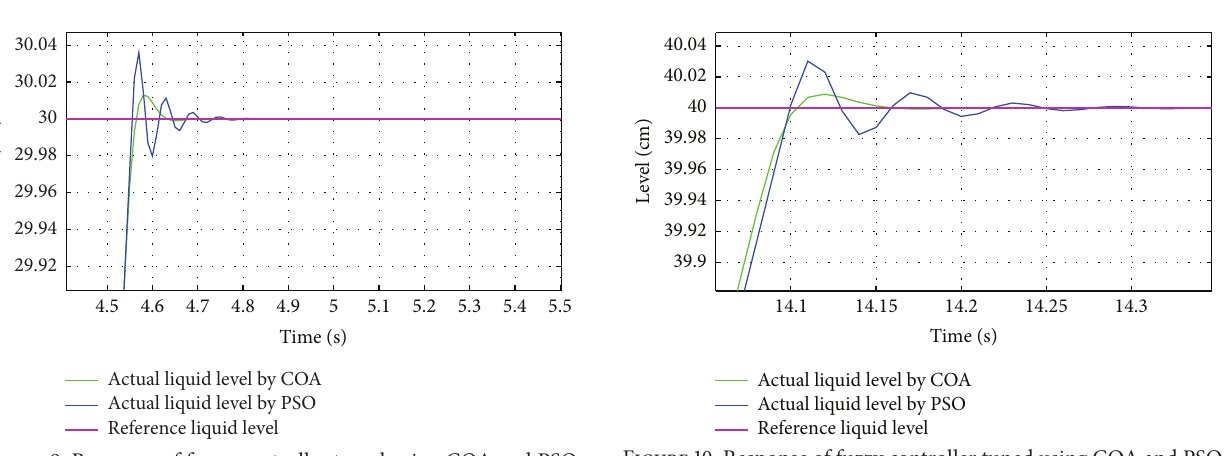
Figure 9: Response of fuzzy controller tuned using COA and PSO (set level = 30 cm at 𝑡 = 0 s).